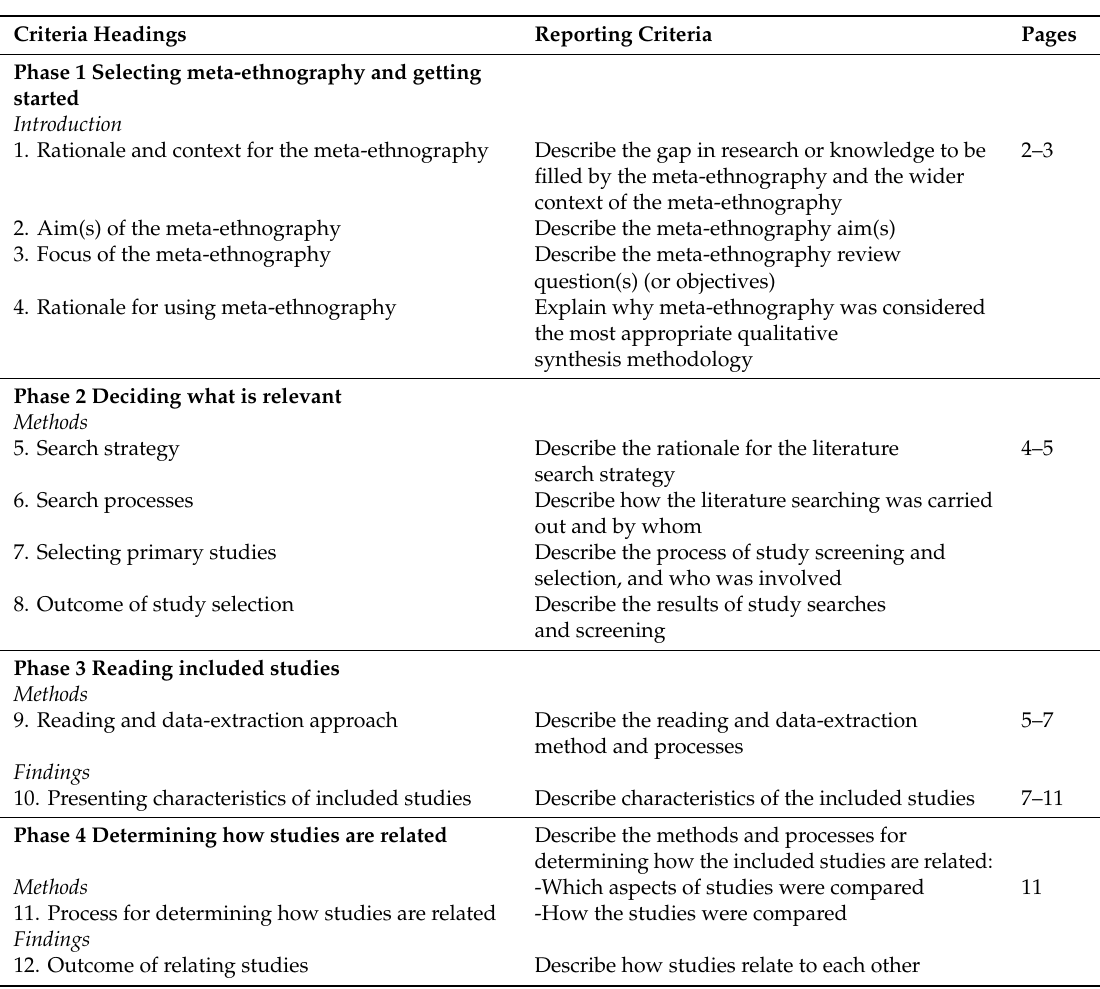
Table A1. The eMERGe meta-ethnography reporting